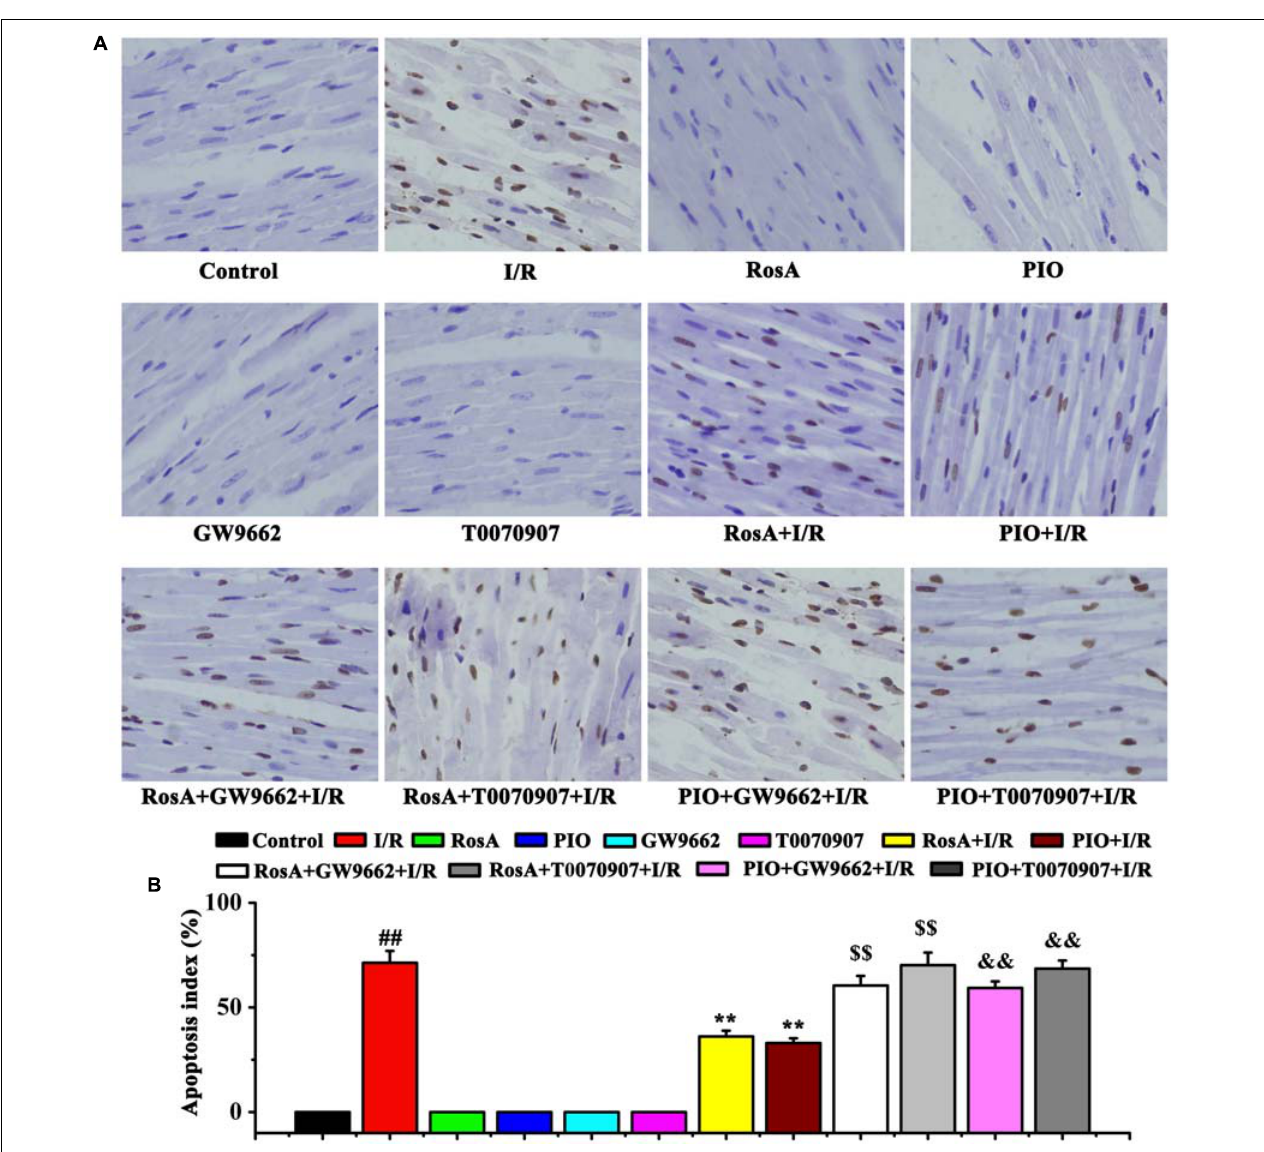
FIGURE 4 | The suppression of RosA in cardiomyocyte apoptosis induced by I/R ( × 200). Brown staining of the nucleus is indicative of apoptosis. (A) The cardiomyocyte apoptosis was measured by TUNEL. (B) Percentage of apoptotic cells. ## P < 0.01 compared to the control group; ∗∗ P < 0.01 compared to the I/R group. Compared with the I/R+RosA group, $ P < 0.05, $$ P < 0.01. Compared with the I/R+PIO group, & P < 0.05, && P <